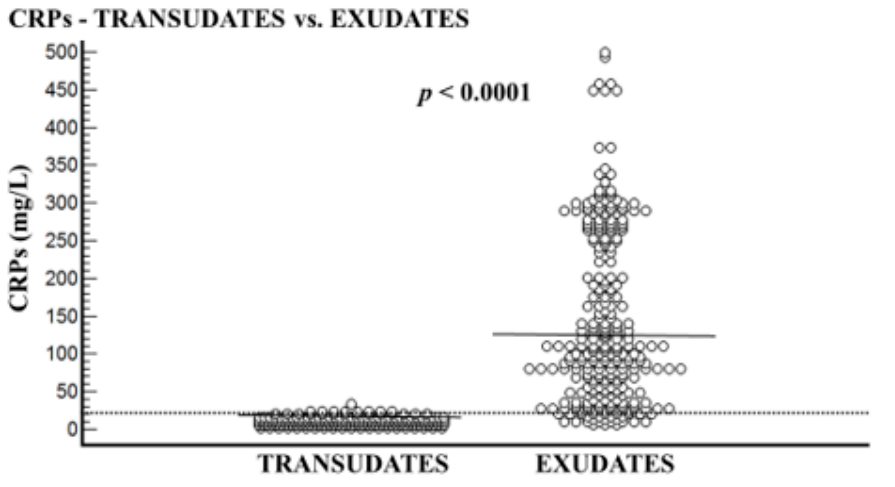
Figure 1. Serum CRP (CRPs) levels and their means for transudate group (11.3 mg/L) and exudate group (140.5 md/L), and best cut-off value (20.5 mg/L) for discrimination between the two groups. For both parameters p < 0.0001.